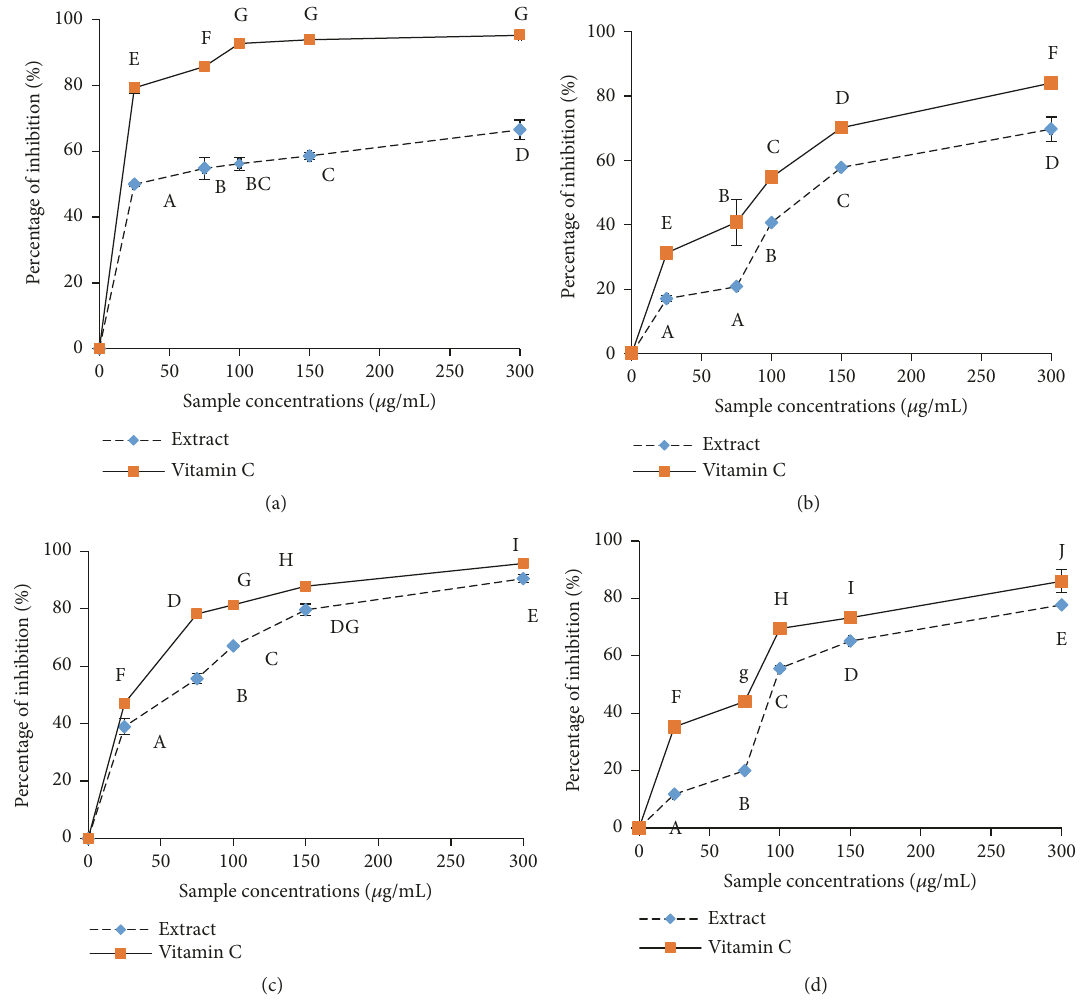
Figure 2: Study of the free radical scavenging effects the water-ethanol extract of Tetrapleura tetraptera ((a) DPPH, (b) ABTS, (c) OH, and (d) NO). Values are expressed as mean ± SD of three replicates. In the same concentration the values affected with different letter are significantly different at p < 0.05. Extract: water-ethanol extract of Tetrapleura tetraptera fruits.